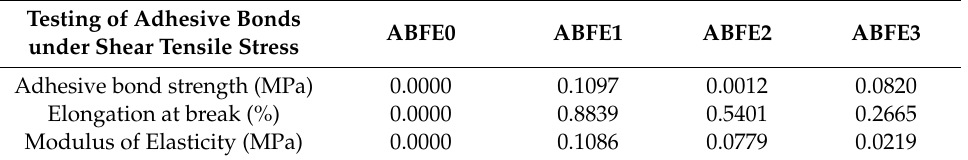
Table 3. Statistical testing of adhesive bonds—adhesive bond shear strength, elongation at break and modulus of elasticity.